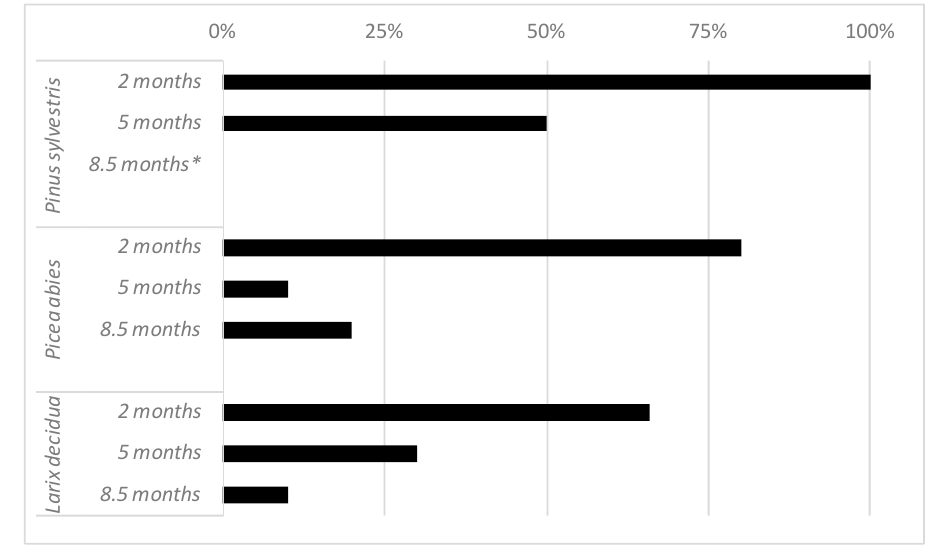
Figure 4. Ratio of positive reisolations of Fusarium circinatum from inoculated seedlings at 2, 5, and 8.5 months after inoculation. (*) All the seedlings were already dead 8.5 months after inoculation and reisolation could not be carried out.